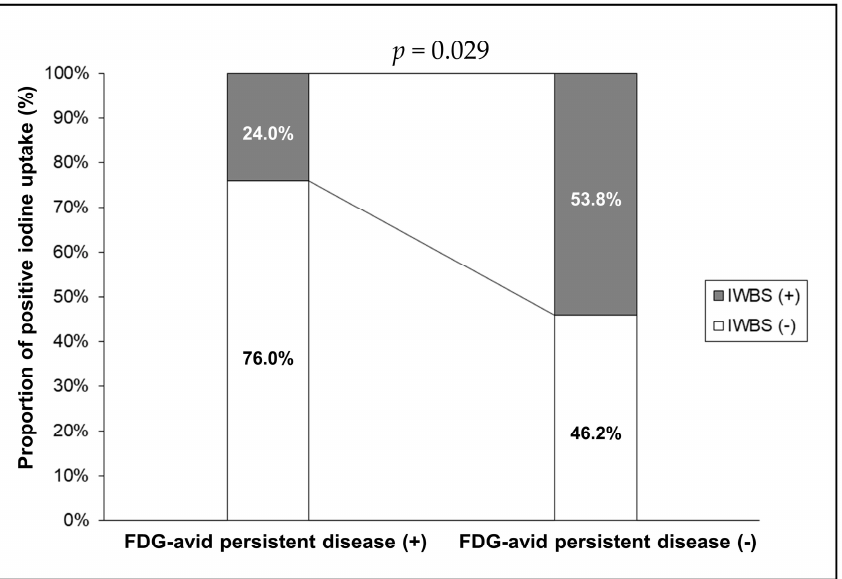
Figure 3. Comparison of iodine uptake positivity on a post-therapeutic iodine whole-body scan (IWBS) according to the presence of FDG-avid persistent disease (PD). Among the 51 patients for whom a [ 18 F]FDG-PET/CT was indicated based on the metastatic lymph node ratio-combined criteria, iodine uptake positivity was defined in those with iodine uptakes in the midline of the anterior neck and in the thyroidectomy bed on IWBS. The proportion of iodine uptake-positive cases was significantly higher in the group without FDG-avid PD (14 of 26 [53.8%] patients) than in the group with FDG-avid PD (6 of 25 [24.0%] patients) ( p = 0.029). The detection rate of FDG-avid PD, according to the LNR-combined criteria, and the comparison of [ 18 F]FDG-PET/CT with IWBS in patients with PTC are shown in Figure